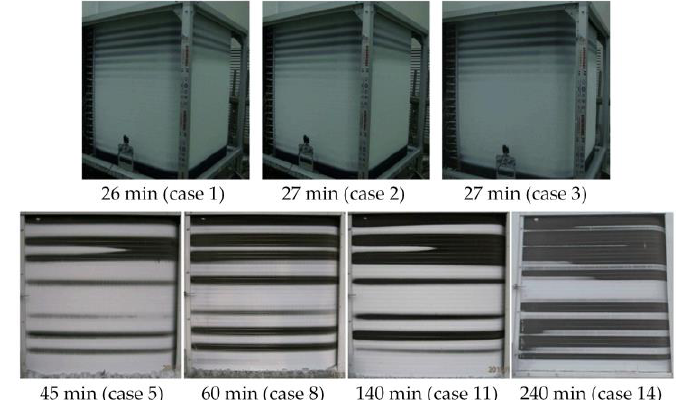
Figure 10. Results of laboratory (Case 1–3) and selected field (Case 5, 8, 11, 14) tests [63].